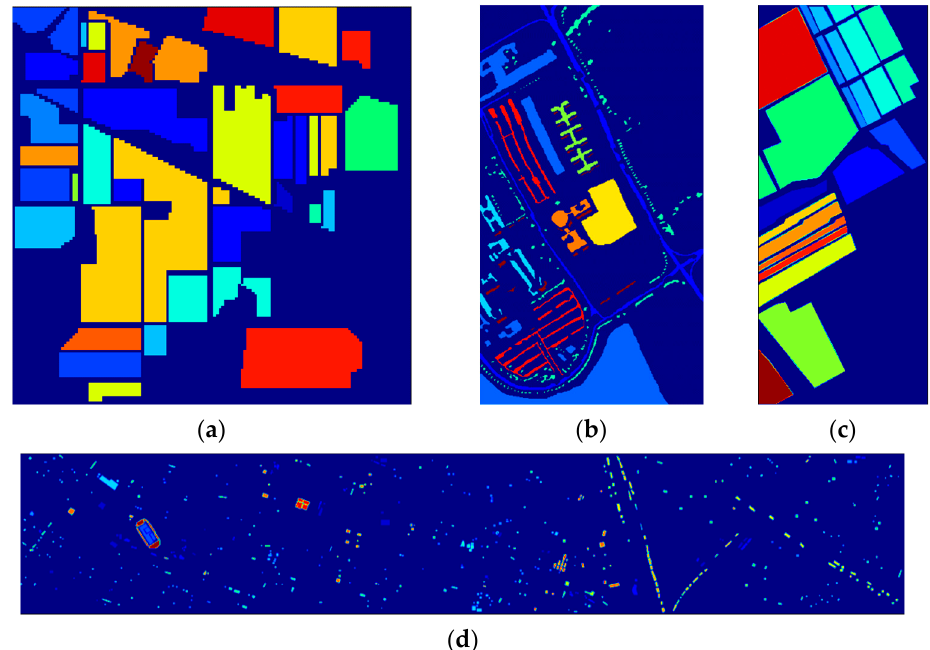
Figure 4. True label images of the four datasets ( a ) IP, ( b ) PU, ( c ) SA, and ( d ) HU.